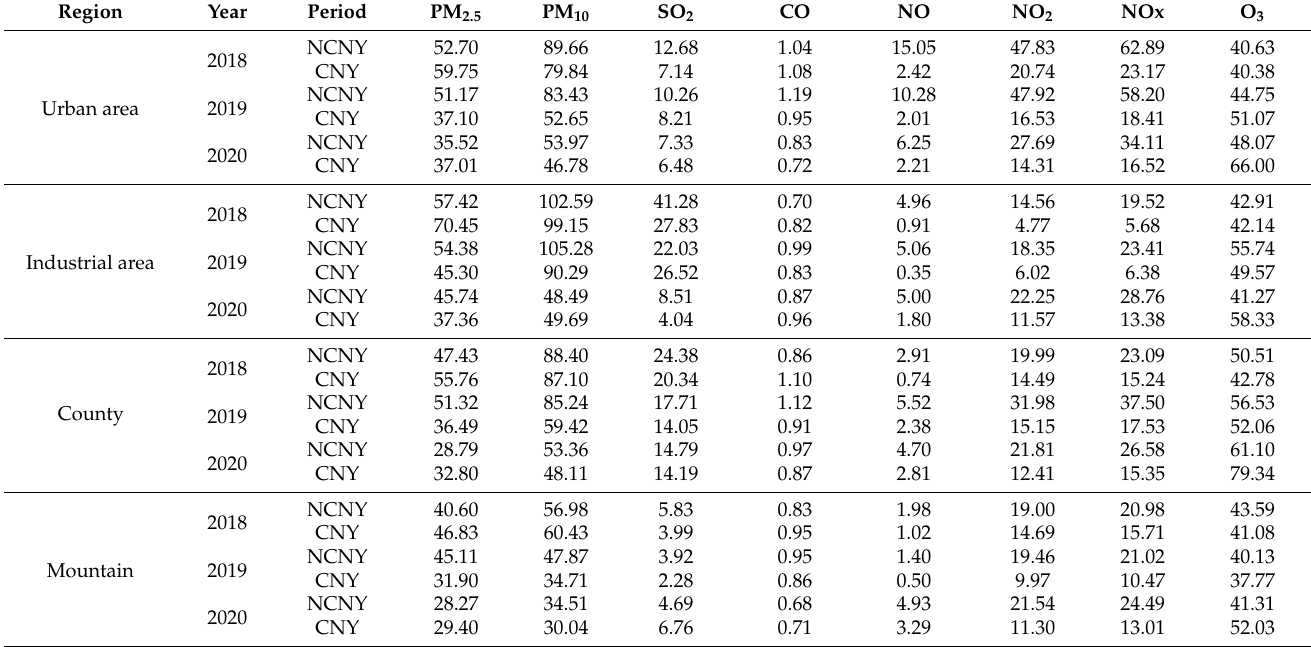
Table 2. Mean concentration of PM 2.5 ( µ g/m 3 ), PM 10 ( µ g/m 3 ), SO 2 ( µ g/m 3 ), CO (mg/m 3 ), NO ( µ g/m 3 ), NO 2 ( µ g/m 3 ), NOx ( µ g/m 3 ) and O 3 ( µ g/m 3 ) in Chinese New Year (CNY) and Non-Chinese New Year (NCNY) for the three periods 2018, 2019, and